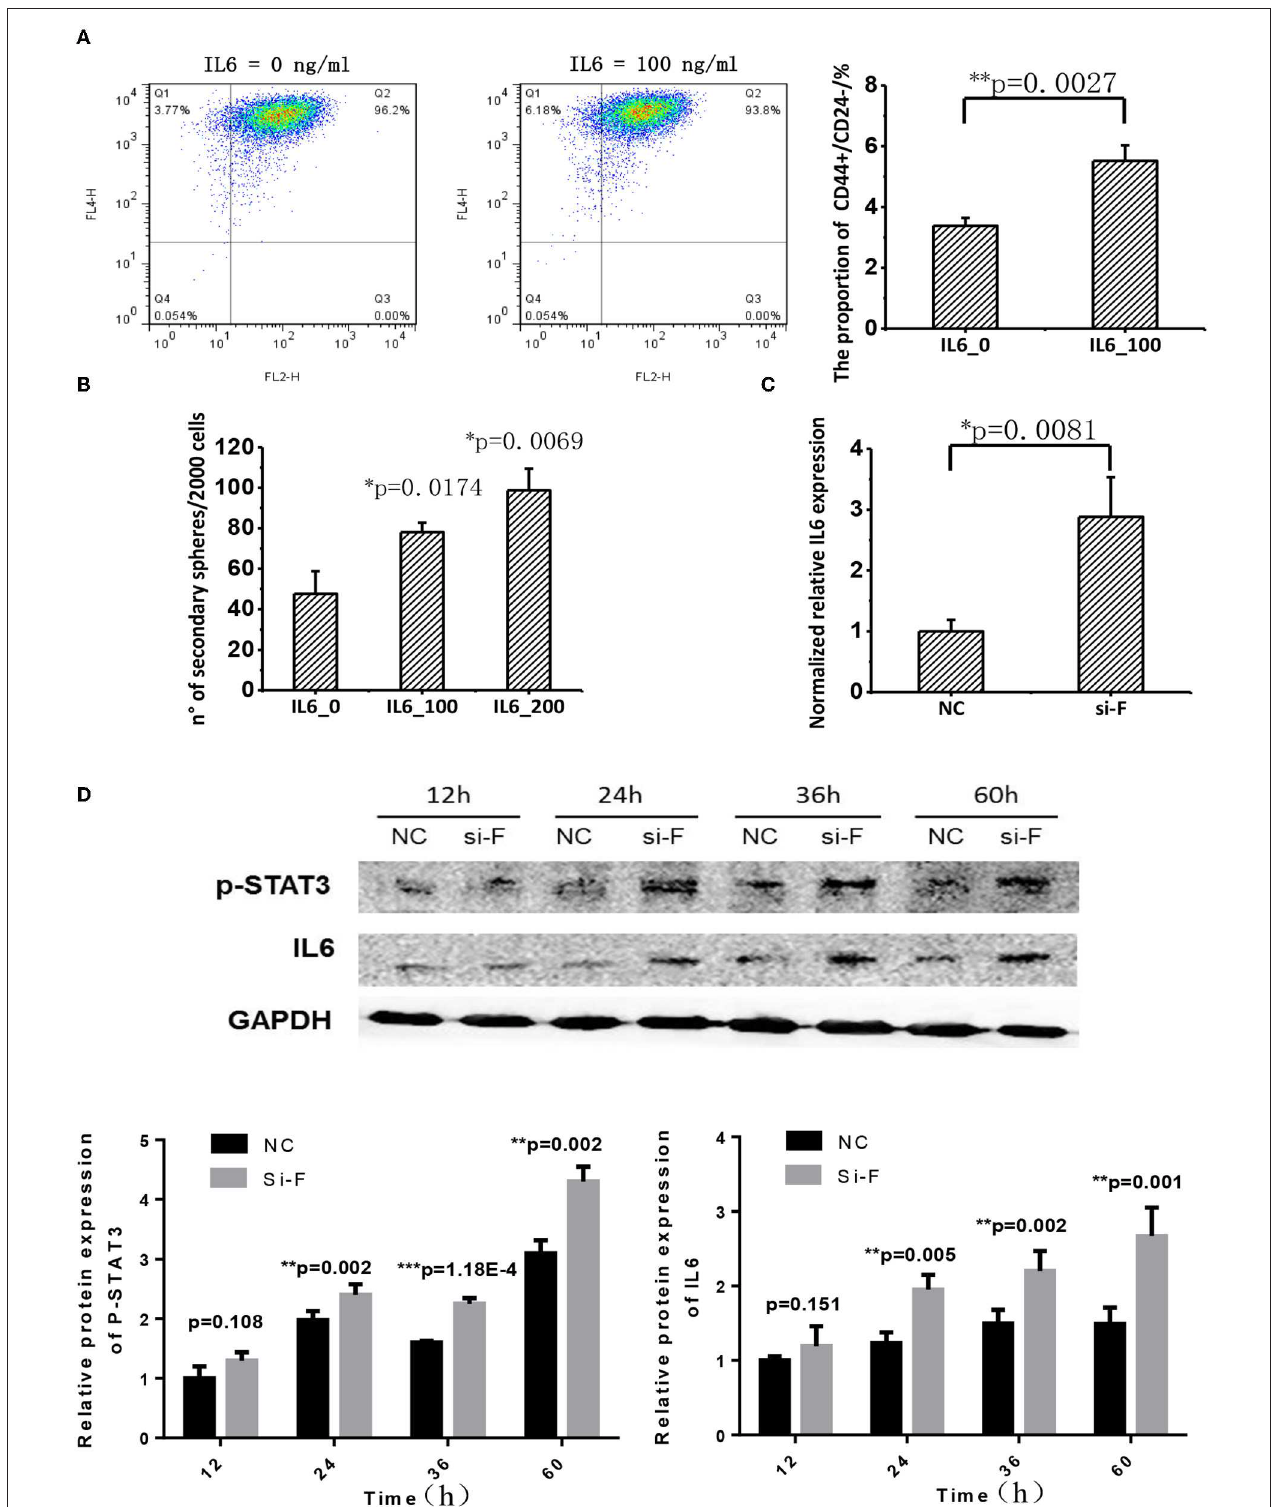
FIGURE 5 | The effect of FA2H on STAT3/IL6 and the effect of IL6 on cancer stemness. (A) Comparisons on CSC percentage after adding IL6 at 100ng/ml. (B) Comparisons on tumorsphere formation after adding IL6 at 100 and 200ng/ml. (C) Silencing efficiency and the effect of silencing FA2H on IL6 gene expression at 36h after transfection. (D) IL6 expression and STAT3 phosphorylation at Tyr705 after silencing FA2H at different time points.